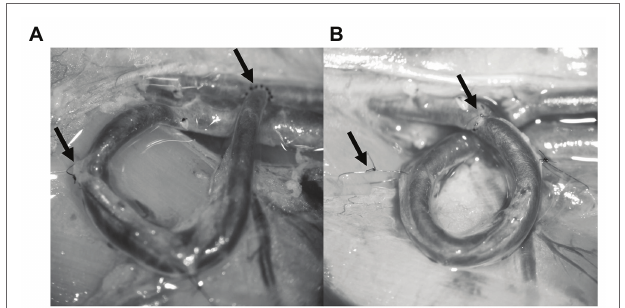
FIGURE 1 | Photos about the finished vascular interventions. The left arrows on each panel show the anchoring stitches, and the right arrows show the anastomosis. (A) U-shaped arterio-venous fistula. (B) Loop-shaped arterio- arterial venous interposition